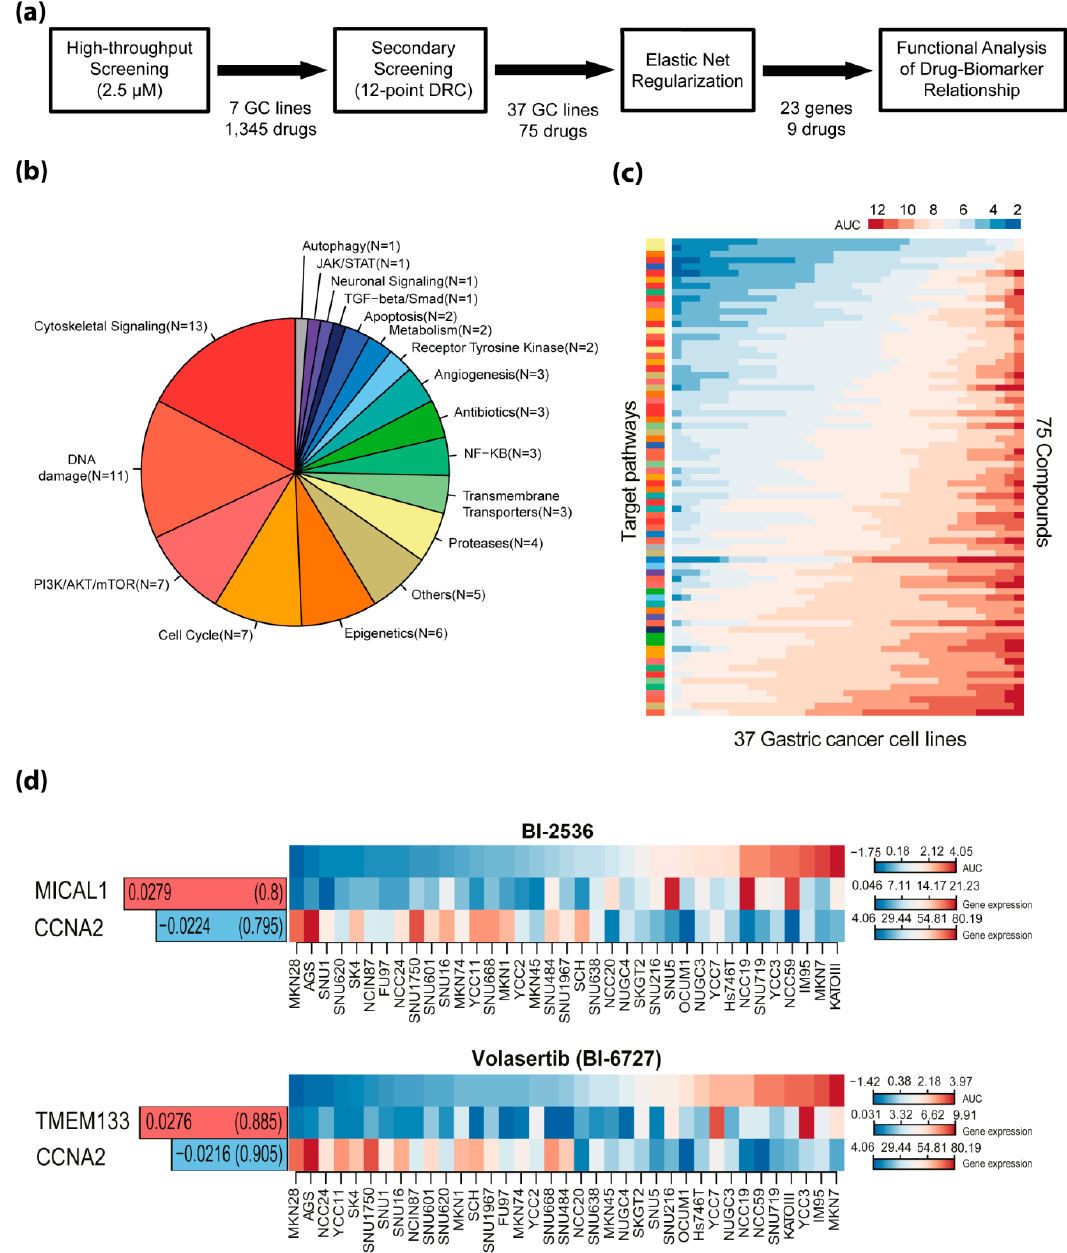
Figure 1. Pharmacogenomic analysis identifies biomarker–drug response relationships. ( a ) Flowchart of overall screening strategy; ( b ) classification of the 75 compounds according to their target pathways; ( c ) sensitivities (area under the viability curve (AUC)) of the 37 gastric cancer cell lines to 75 compounds are ordered by row. Rank-ordered original AUC values are indicated as a heat map. Heat mapsare colored on a blue (sensitive) to white to red (resistant) gradient scale of original AUC values. Target pathways for each compound are annotated by the same color code as in b; ( d ) representative biomarker and drug response relationships by elastic net regularization method. The average weights of features are displayed in bar plots and their frequencies are shown in parenthesis.Bar plots on the left are colored in red when the expression level of a biomarker is positively correlated with the resistance of the given drugs and colored in blue when negatively correlated. Heat mapsaredepicted on a blue–white–red gradient scale of median-centered AUC values and expression levels (FPKM) of genes, respectively.